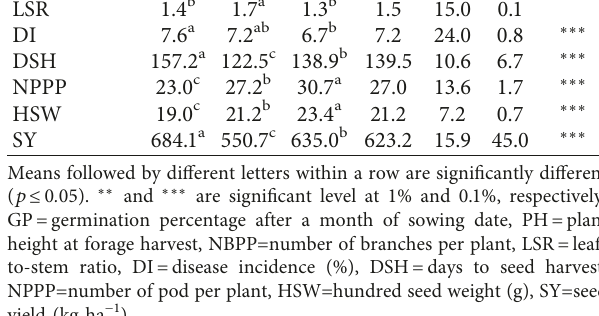
Location ValueTepi